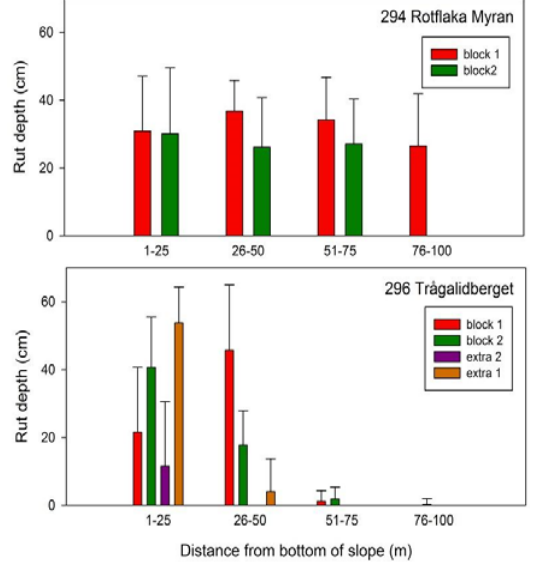
Figure 7. Rut depth in study plots subjected to repeated passes by a laden forwarder in the study-plot experiments (means for the left and right wheel tracks). The rut depth was not measured in case the mineral soil was unexposed in the track. The colors of the bars correspond to the plots in the map (Figure 6) and the error bars represents the standard